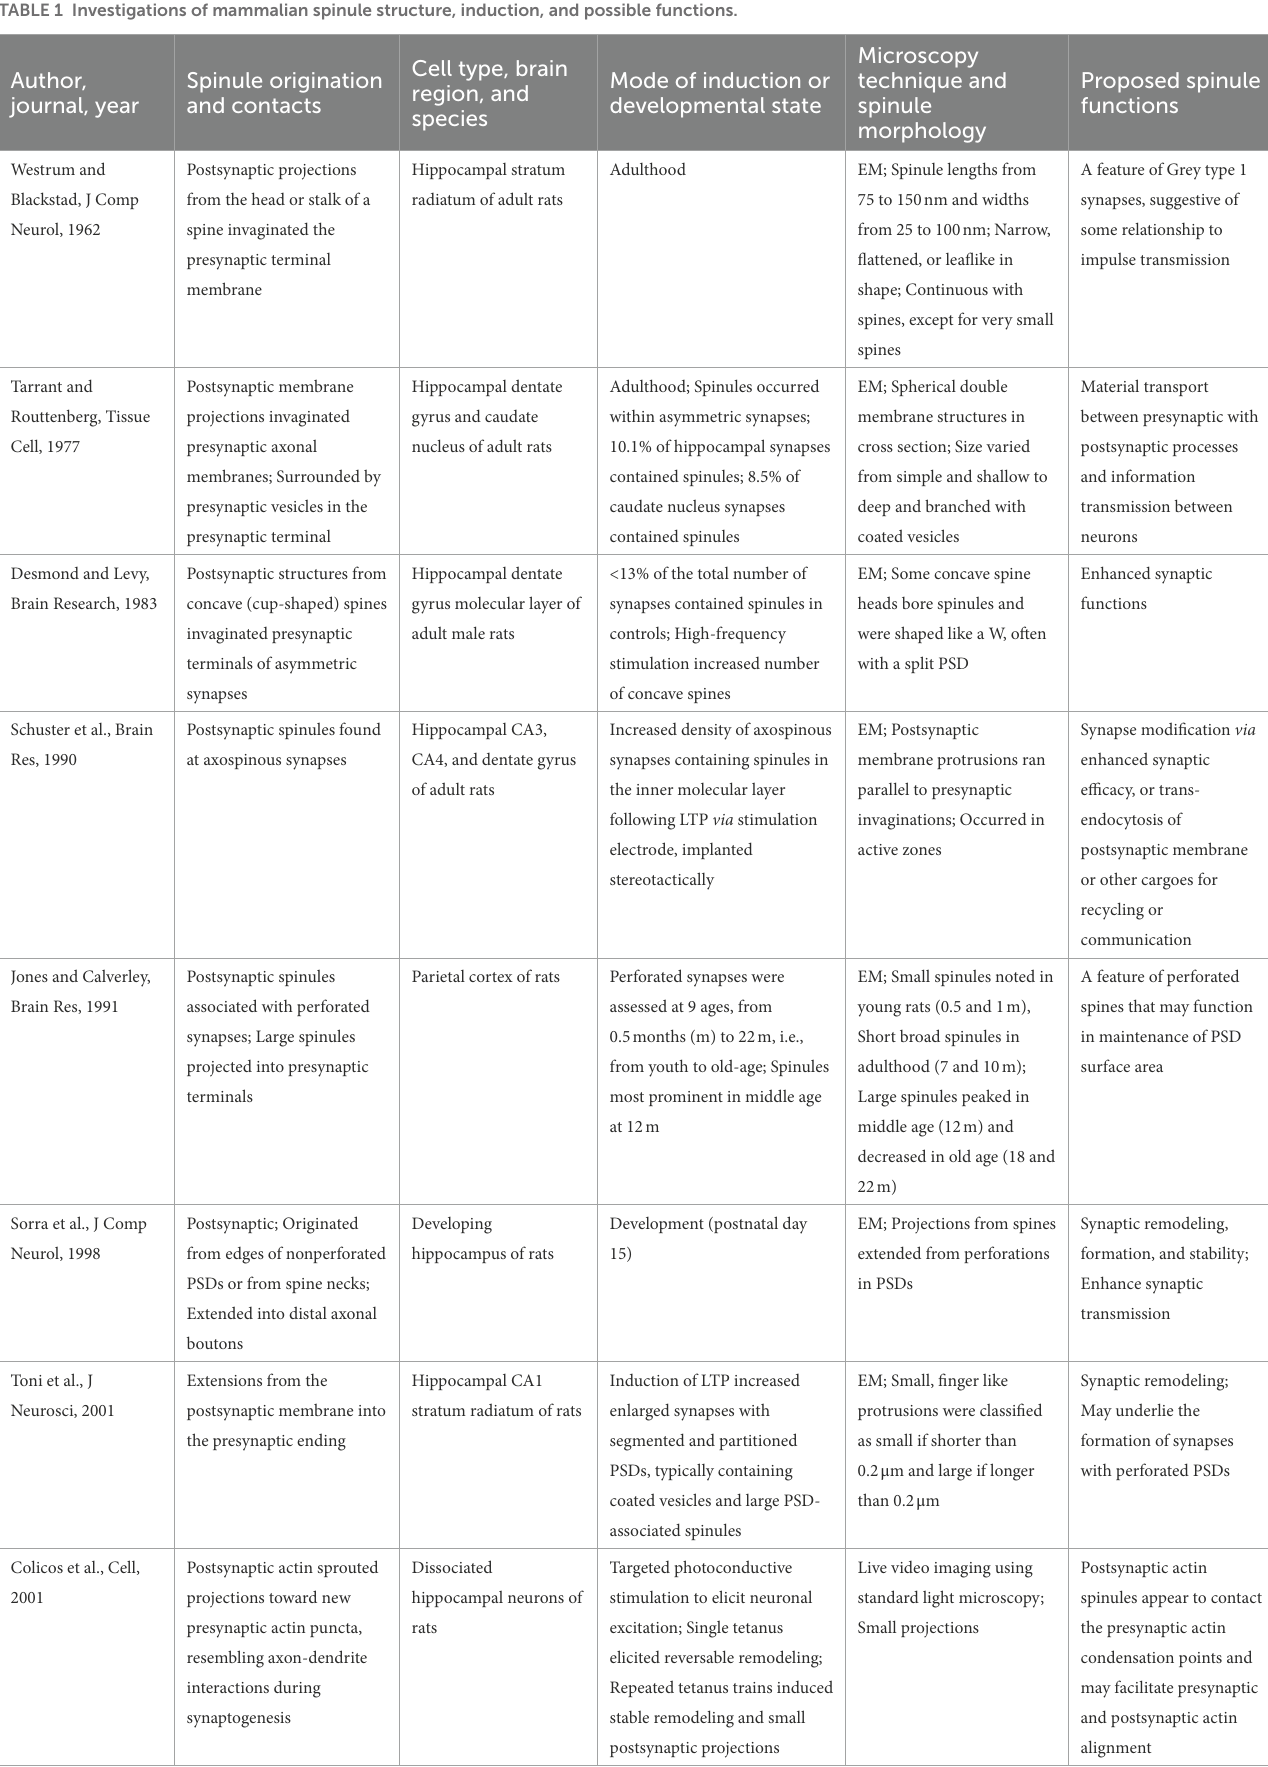
TABLE 1 Investigations of mammalian spinule structure, induction, and possible